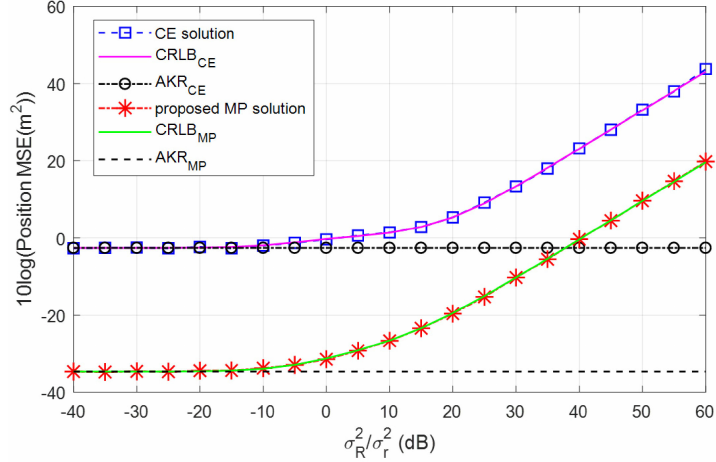
Figure 6. Performance of a near acoustic target and a near calibration source.